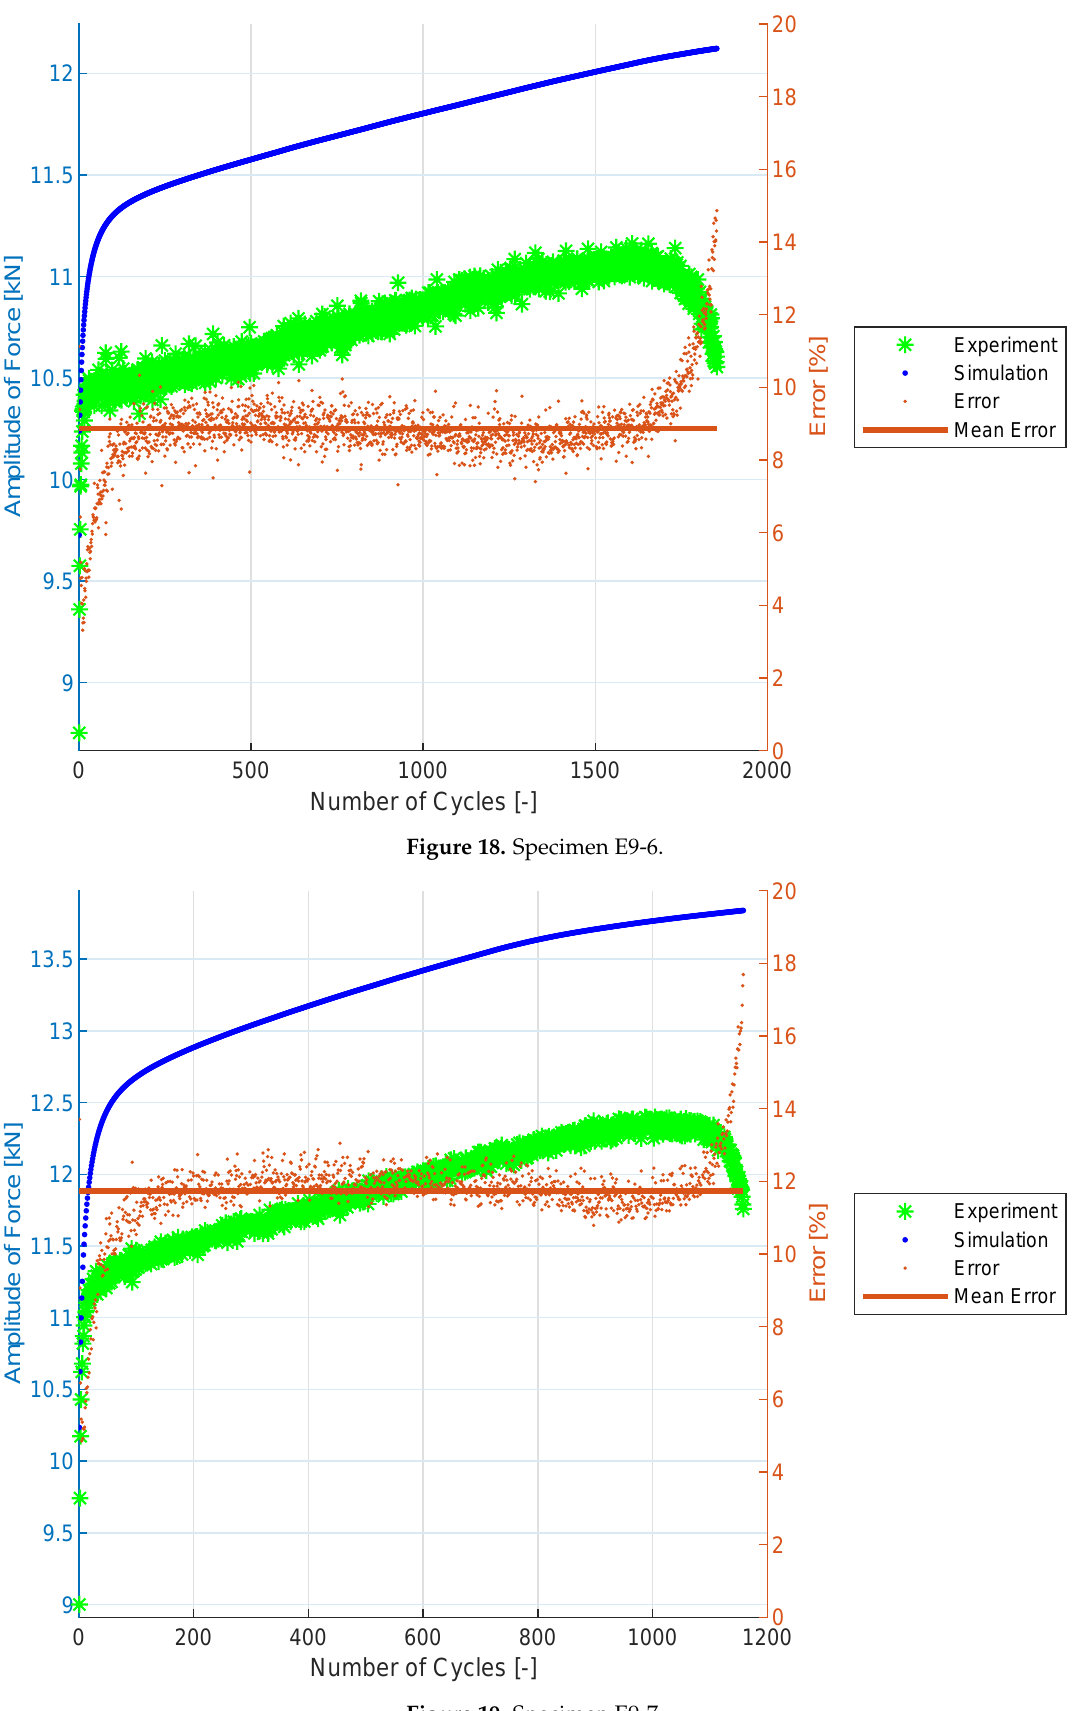
Figure 19. Specimen